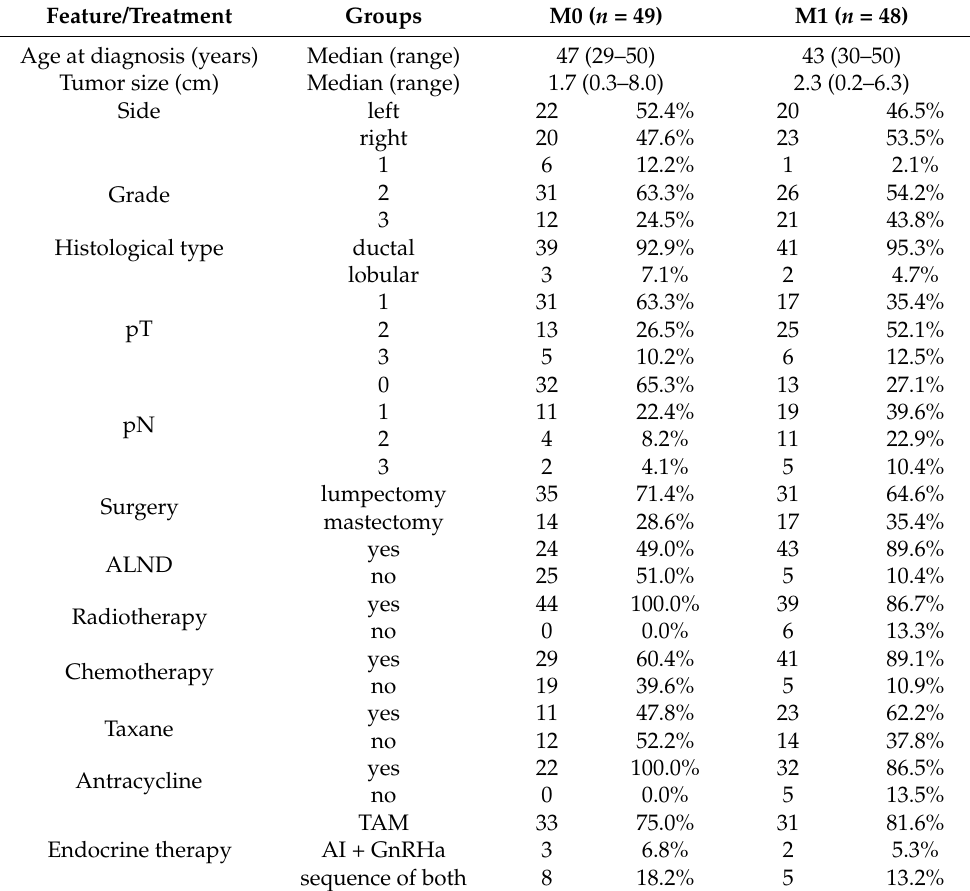
Table 1. Patient